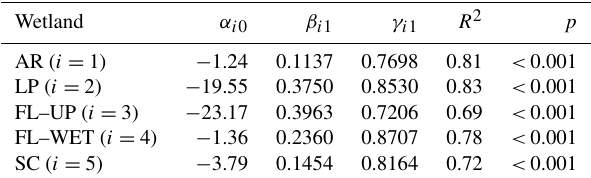
Table 3. Results for regressions of the water table for five wetlands in the SE United States.